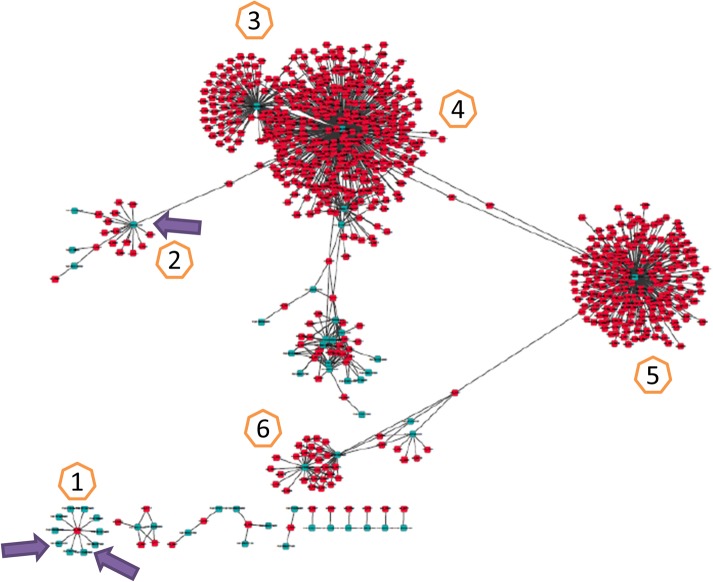
The independent network inferred from the top 1000 fungus-poplar relationships.Individual genes simultaneously connected with many other genes were sequentially marked as 1, 2, 3, 4, 5, and 6. Mark 1 represents a fungal metalloprotease gene that was surrounded by 10 poplar genes, including 2 DR genes; mark 2 is a poplar DR gene that is connected to 16 fungal genes. Marks 3 and 5 are the poplar genes secretory carrier 3 and NAD(P)-binding Rossmann-fold superfamily protein, respectively; marks 4 and 6 are poplar genes with unknown functions. The three arrows denote the position of 3 DR genes. The fungal genes are shown in red, and the poplar genes are shown in blue.